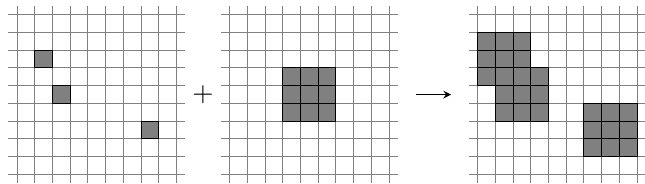
Figure 6. An illustration of the Minkowski sum in eq. (3.2). The most left (cid:12)gure shows the active pixels P (0) , the (cid:12)gure at the center shows the pixels whose centers are B (1) , and P (1) is shown in the right (cid:12)gure.